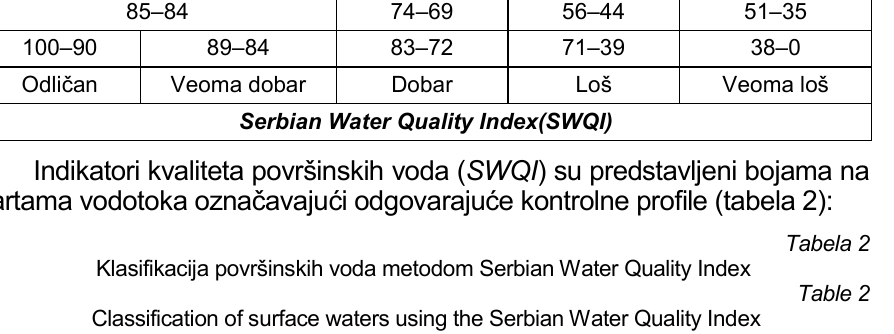
Classification of surface waters using the Serbian Water Quality Index WQI - МДК I класа